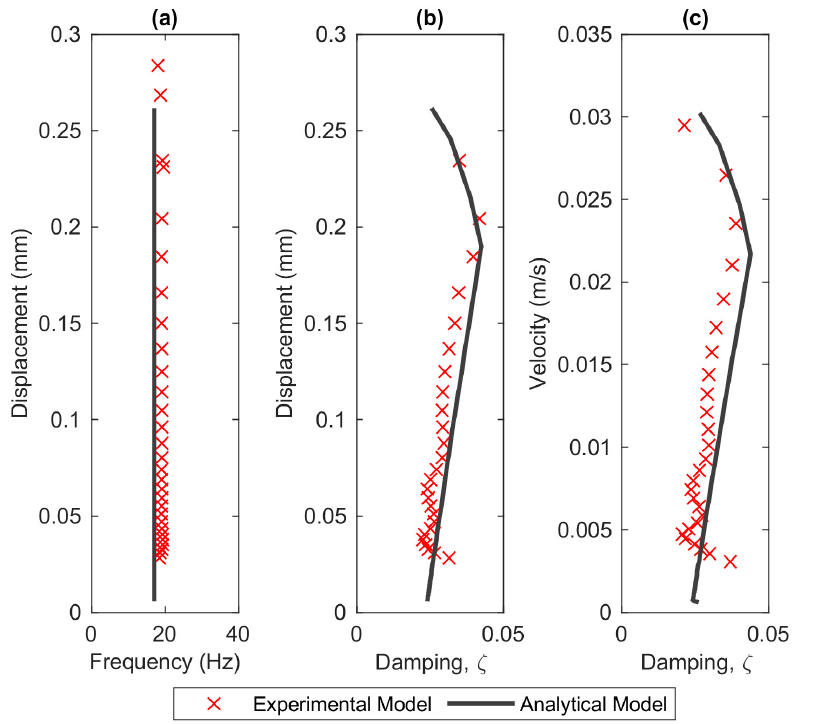
Figure 21. ( a ) The backbone curve, and the damping curves with respect to ( b ) displacement and ( c ) velocity.